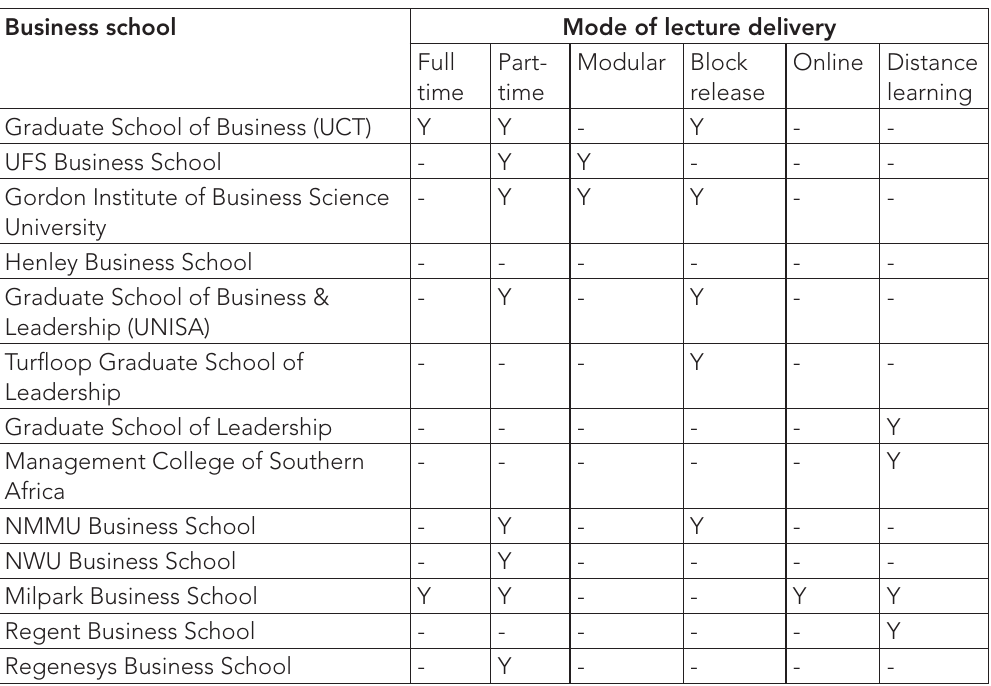
Table 6: Mode of